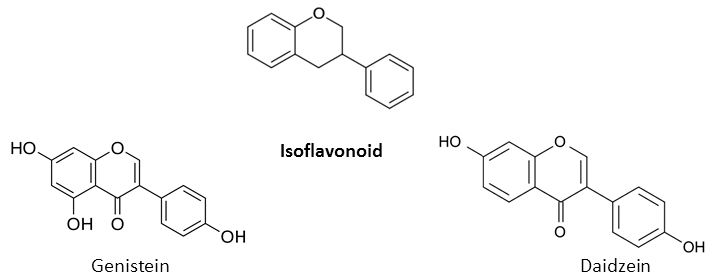
Figure 2. Chemical structures of the main isoflavonoids.